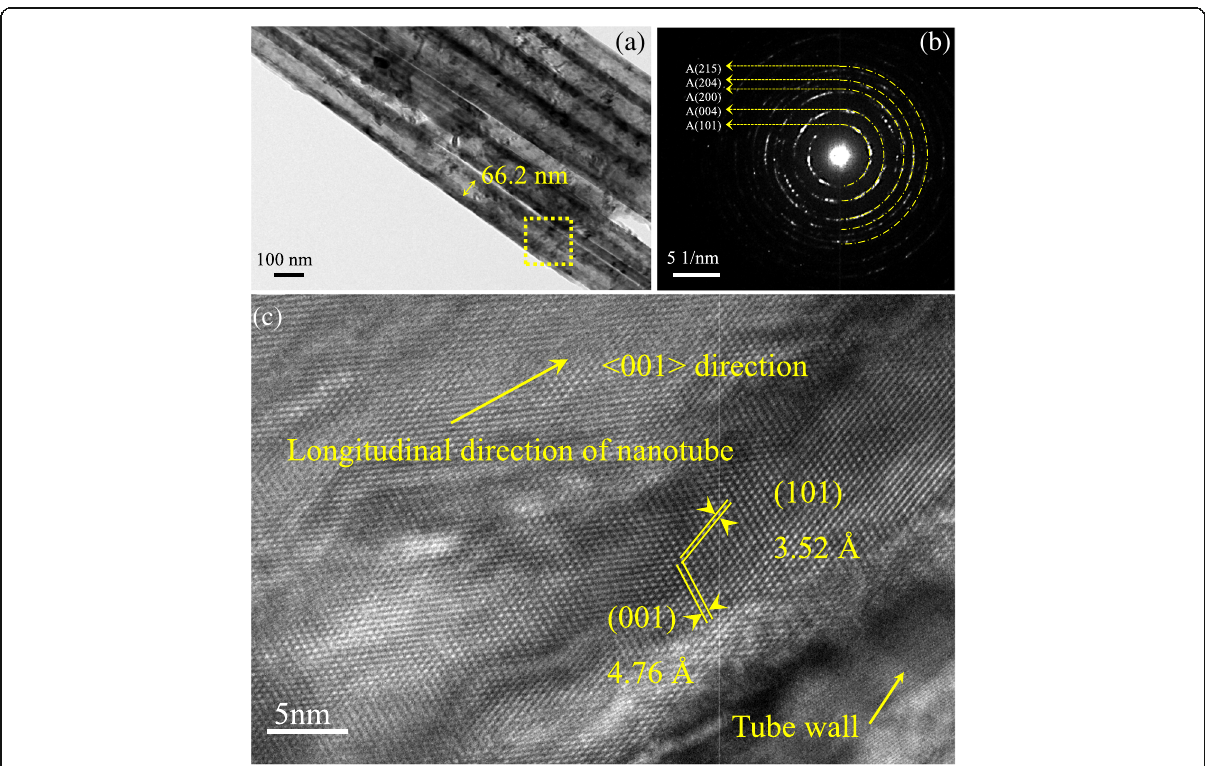
Fig. 4 a TEM image of H@TNAs-1. b Corresponding selected area electron diffraction (SAED) patterns of the dotted area in a. c High-resolution TEM (HR-TEM) image of